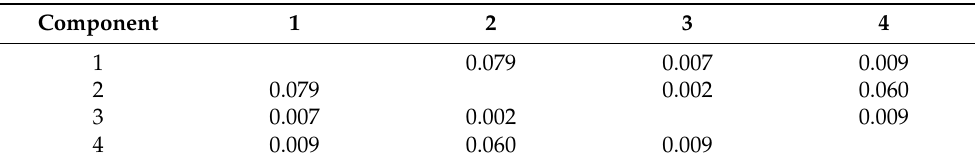
Table 3. Component correlation matrix